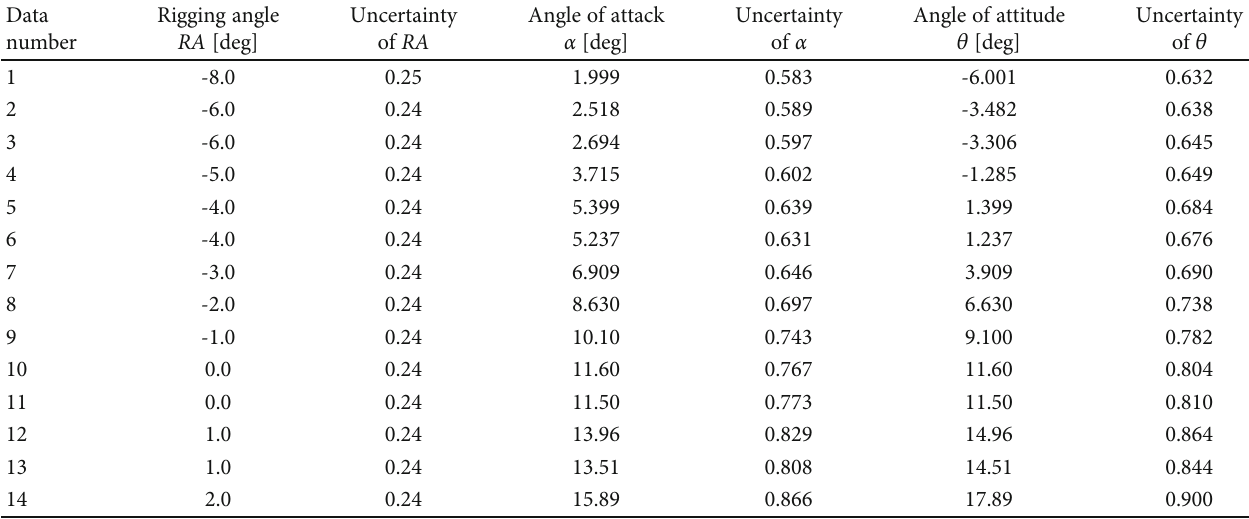
Table 8: Wind tunnel test result of 70Pa wind